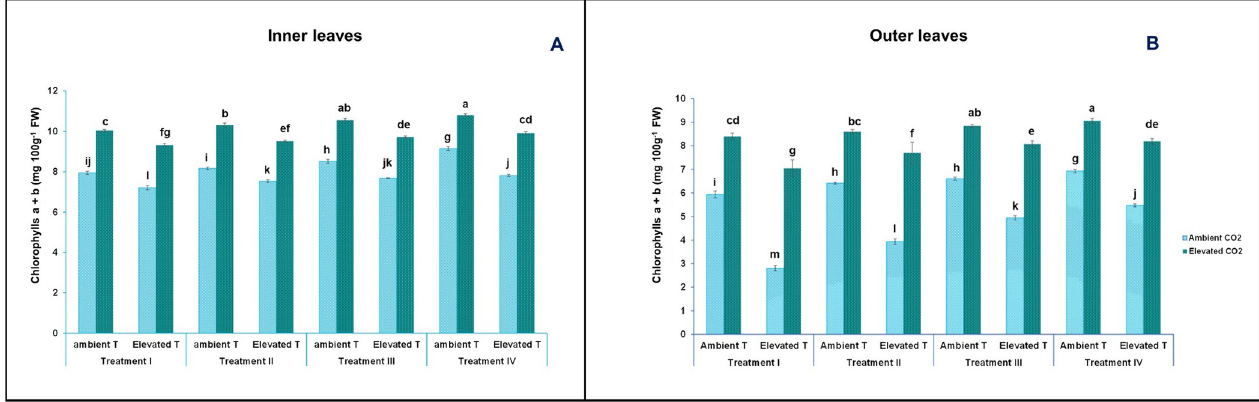
Fig 5. Effect of short-term heat stress on concentrations of chlorophylls a + b in inner (A) and outer (B) leaves of the baby-leaf lettuce cv Derbi at two different levels of CO 2 and at four different NO 3- / NH 4+ treatments. Different letters are significantly different according to Tukey’s test at p � 0.05.